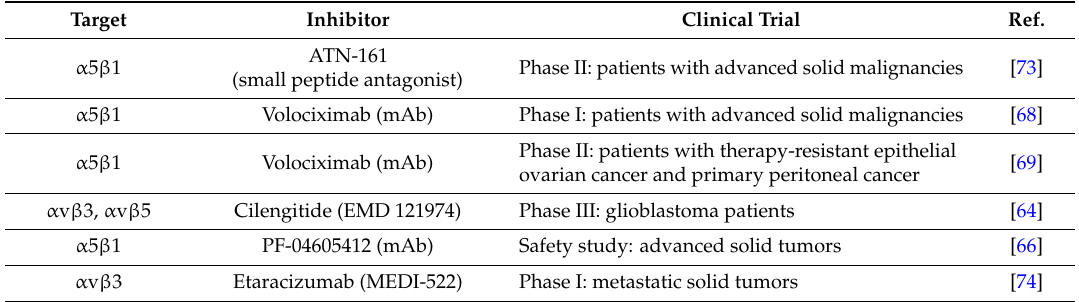
Table 2. Selection of integrin inhibitors for cancer therapy in clinical studies. Reports of all clinical trial summary results are published on